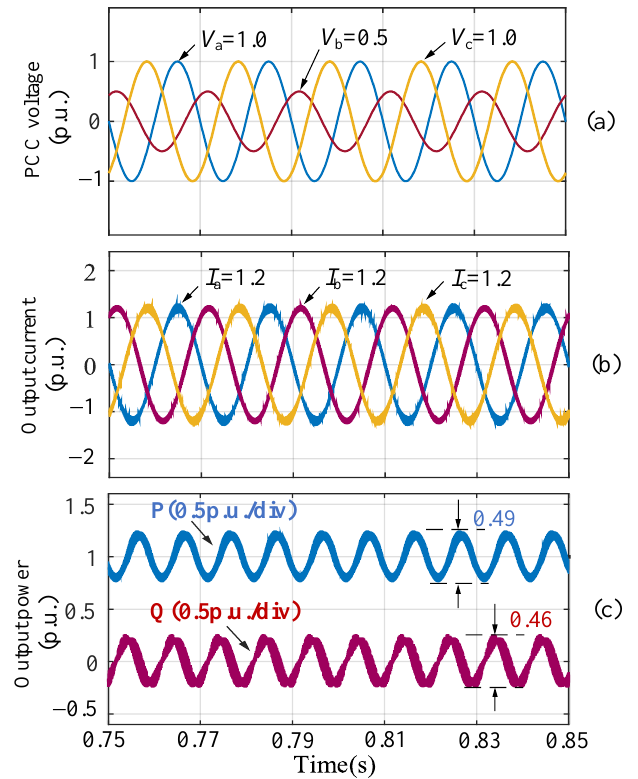
Figure 11. Simulation results of the traditional topology, when V b drops to 0.5 p.u. ( a ) Output voltage at PCC 1 ; ( b ) output current; ( c ) output active power and reactive power.